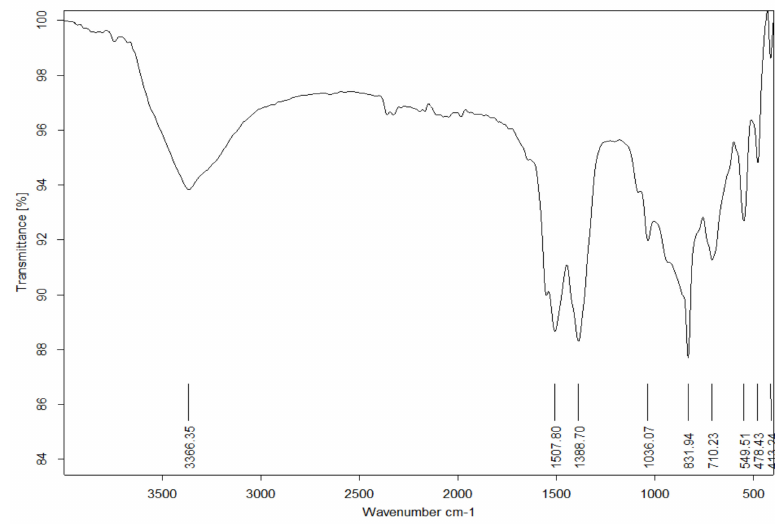
Figure 3. FTIR spectra of the ZnO NPs.